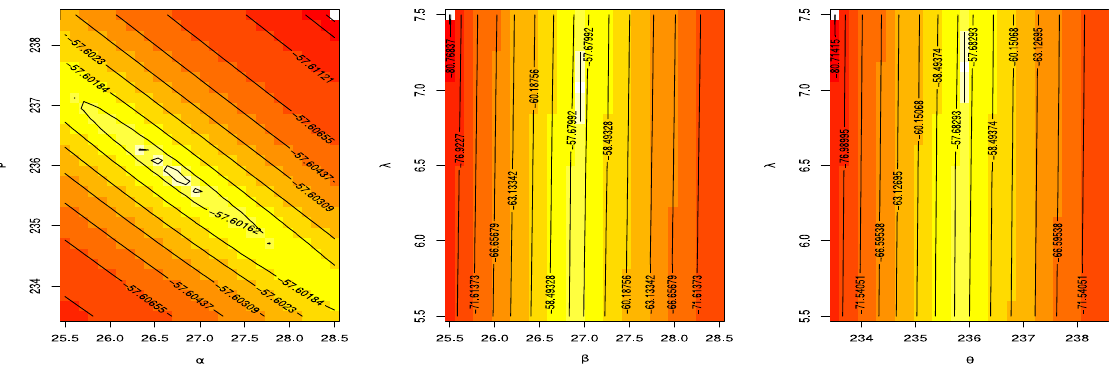
Figure 5. Graphs of profile log-likelihood function for the parameters for the APIW model.